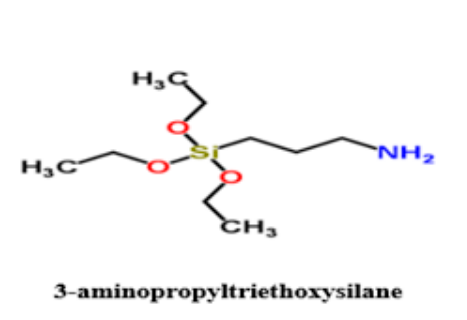
Figure 1. Chemical structure of 3-aminopropyltriethoxysilane (APTES) and 3-glycidylpropyltrimethoxysilane (GPTES).